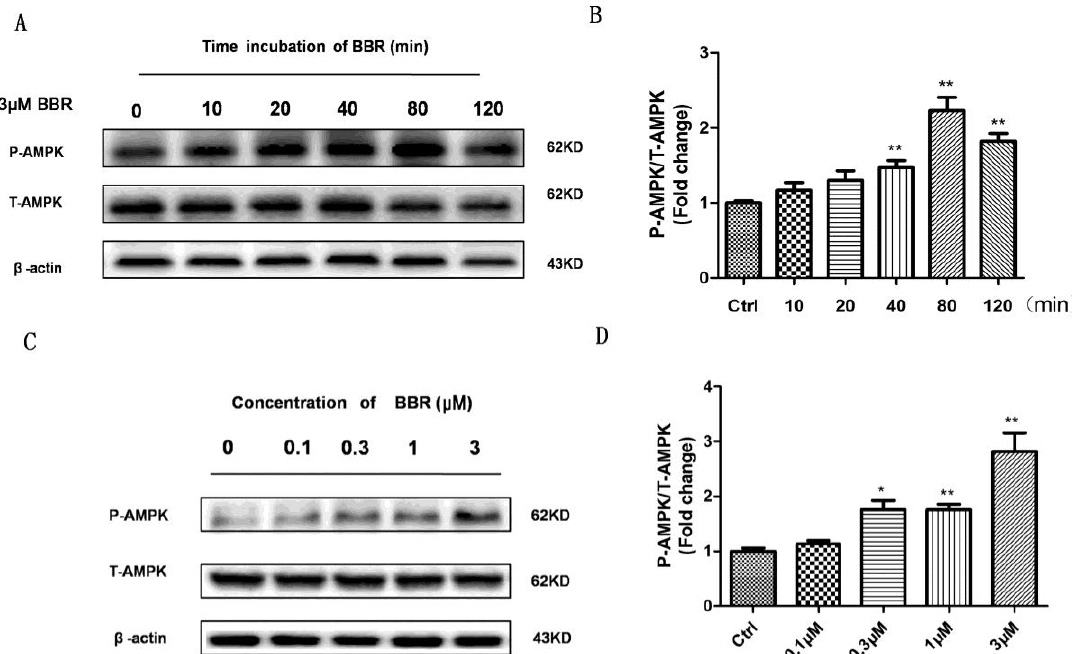
Figure 5. BBR stimulated AMPK phosphorylation in D407 cells. ( A ) D407 cells were treated with 3 µ M BBR for various time points as indicated in the Figure and the phosphorylation of AMPK (P-AMPK), total AMPK (T-AMPK), and β -actin were detected by Western blotting with specific antibodies; ( B ) Quantification of representative protein band from Western blotting. * p < 0.05 versus the control group was considered significantly different; ( C ) D407 cells were treated with various concentrations of BBR for 80 min and the expression of phosphorylated AMPK (P-AMPK), total AMPK (T-AMPK), and β -actin were detected by Western blotting with specific antibodies ( D ). Quantification of representative protein band from Western blotting. * indicate p < 0.05, ** indicate p < 0.01 versus the control group was considered significantly different.